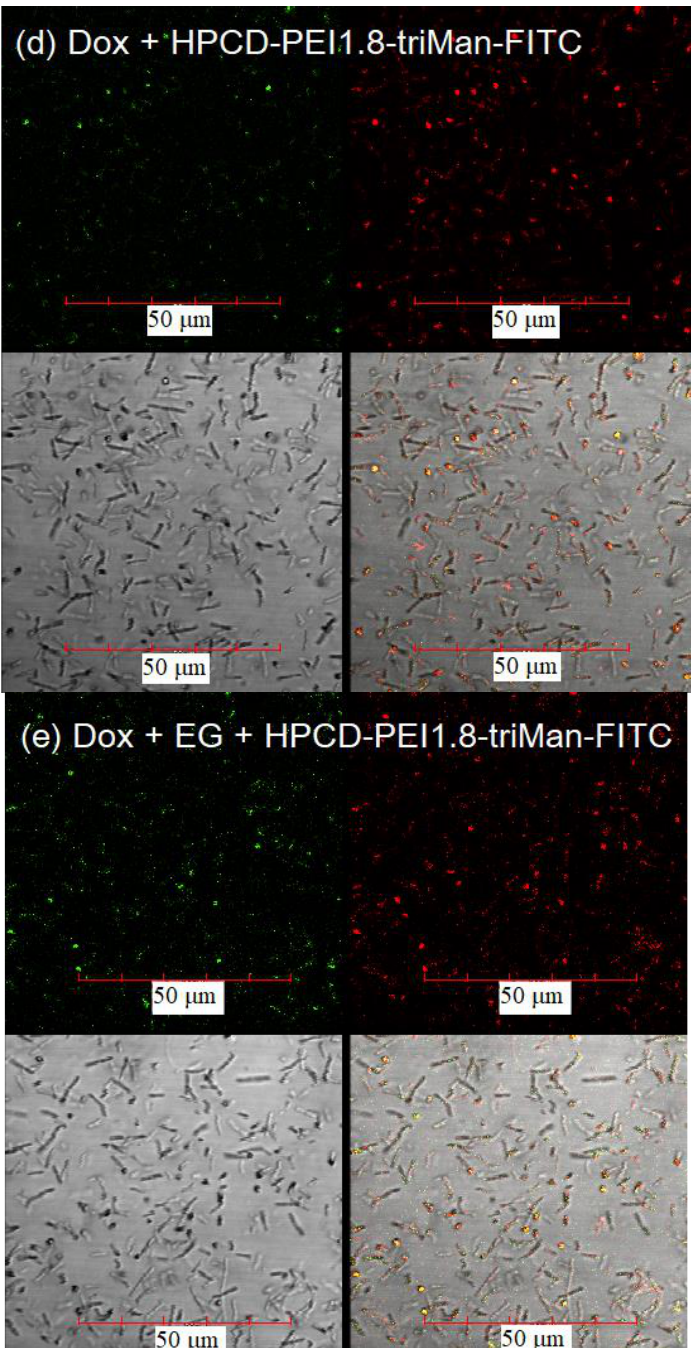
Figure 8. Confocal laser scanning images of B. subtilis with adsorbed and absorbed Dox and FITC- labeled ligands based on PEI, HPCD, and triMan. ( a ) Dox-free. ( b ) Simultaneously added Dox + EG (0.1 mg/mL) as a membrane destroyer and protein efflux inhibitor. ( c ) Dox + EG (0.1 mg/mL) only as a protein efflux inhibitor, where EG is added in advance and then washed using SDS. ( d ) Dox + FITC-HPCD-PEI1.8-triMan. ( e ) Dox + EG + FITC-HPCD-PEI1.8-triMan. The scale segment is 50 µ m (division value is 10 µ m); 30 min of incubation (except for point ( b )). C 0 (Dox) = 1.3 µ g/mL. C 0 (FITC) = 0.2 µ g/mL; 3–4 channels are shown: red, Dox; green, FITC; gray, transmission light mode; and overlay. Emission fluorescence spectra of FITC and Dox obtained by CLSM are presented in Figure S10, λ em = 488 nm (multiline Argon